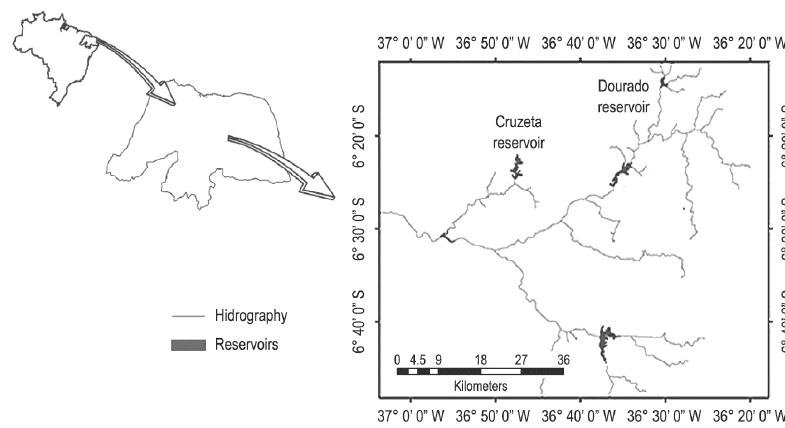
Figure 1. Location of Dourado and Cruzeta reservoirs in Rio Grande do Norte State,